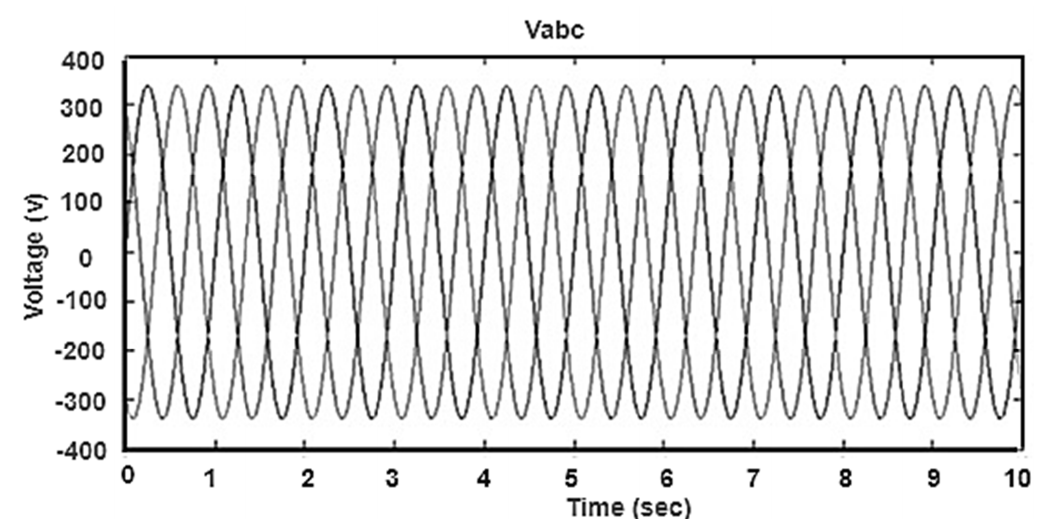
Figure 9. Output voltage of three-phase induction motor.